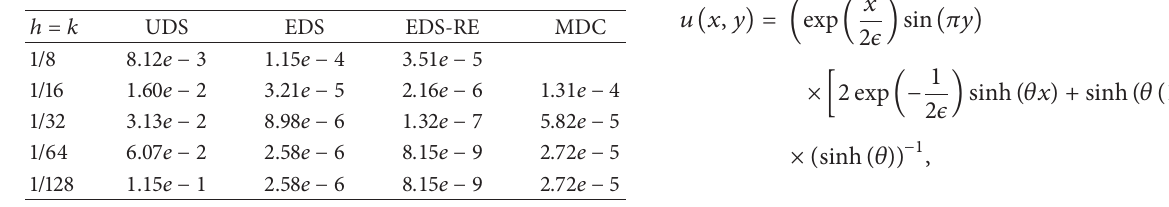
Table 8: Max absolute error in the computed solution, Example 10 with 𝜖 = 0.001 .